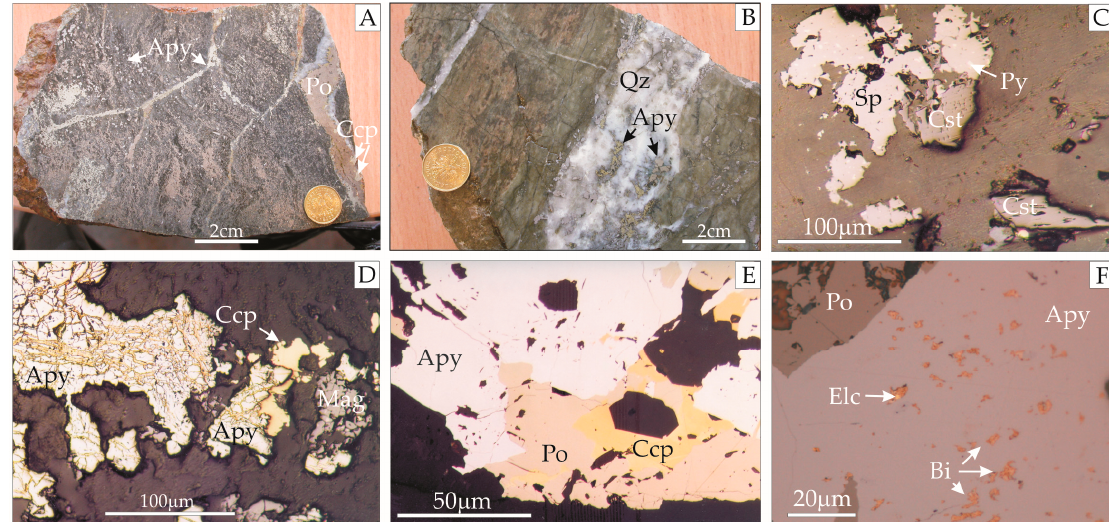
Figure 6. ( A – F ) Typical ore mineralization from the Czarnów As-polymetallic deposit: ( A ) macro-photographs of fractured massive pyrrhotite (Po) ore with chalcopyrite (Ccp) cemented by younger generation arsenopyrite (Apy); ( B ) Arsenopyrite (Apy) disseminated mineralization in quartz vein (Qz) hosted by calc-silicate skarn; ( C ) Photomicrograph under reflected light of fine-grained aggregates of cassiterite (Cst) and sphalerite (Sp), which contains disseminated pyrite (Py); ( D ) Highly fractured arsenopyrite cemented by chalcopyrite (Ccp), with associated magnetite (Mag); ( E ) finely crystalline sulfide aggregate of arsenopyrite (Apy), pyrrhotite (Po), and chalcopyrite (Ccp); ( F ) finely disseminated electrum (Elc) and native bismuth and bismuth minerals (Bi) hosted by massive arsenopyrite (Apy) and pyrrhotite ore (Po).